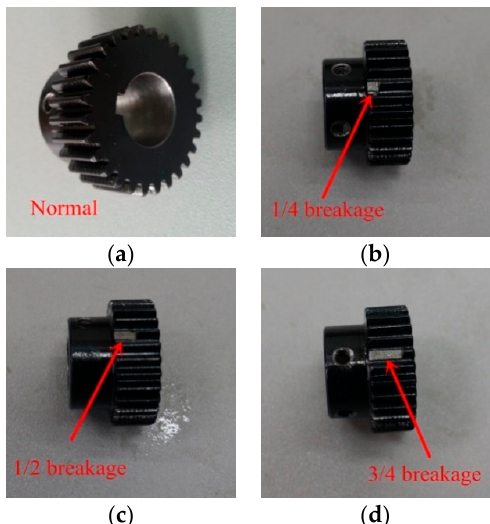
Figure 12. Four breakage degradation states: ( a ) normal gear, ( b ) one-quarter breakage, ( c ) one-half breakage, and ( d ) three-quarters breakage.